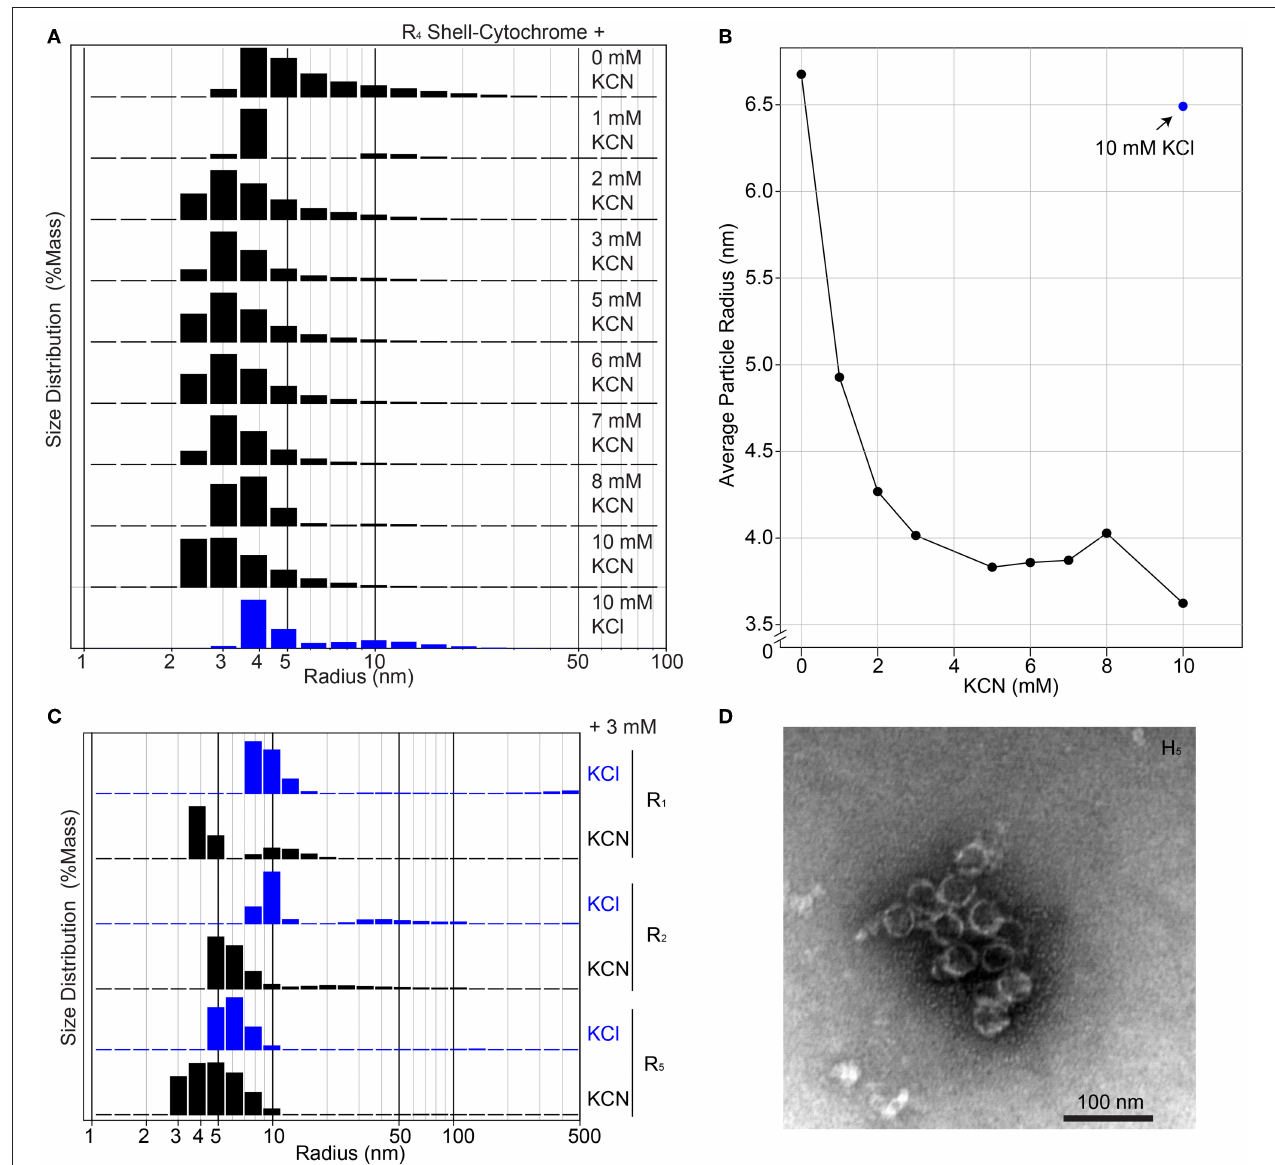
FIGURE 4 | Higher-order assembly of shell-cytochromes. (A) Titration of potassium cyanide against 200 µ M R 4 shell-cytochrome (based on heme concentration) at pH 7.8 monitored by Dynamic Light Scattering. (B) Titration curve of (A) , showing the mass-weighted average particle sizes in different concentration of KCN. (C) Particle sizes of 200 µ M shell-cytochromes R 1 , R 2 and R 5 with 3mM KCN. (D) Representative TEM micrograph of spherical shells (often broken) formed by combining H 5 with H. ochraceum BMC-P and BMC-T in an in vitro assembly reaction, as described in Hagen A. R. et al.